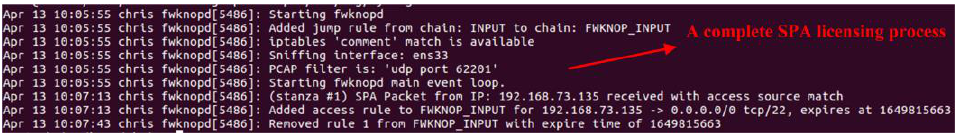
Figure 11. An SPA interaction process.